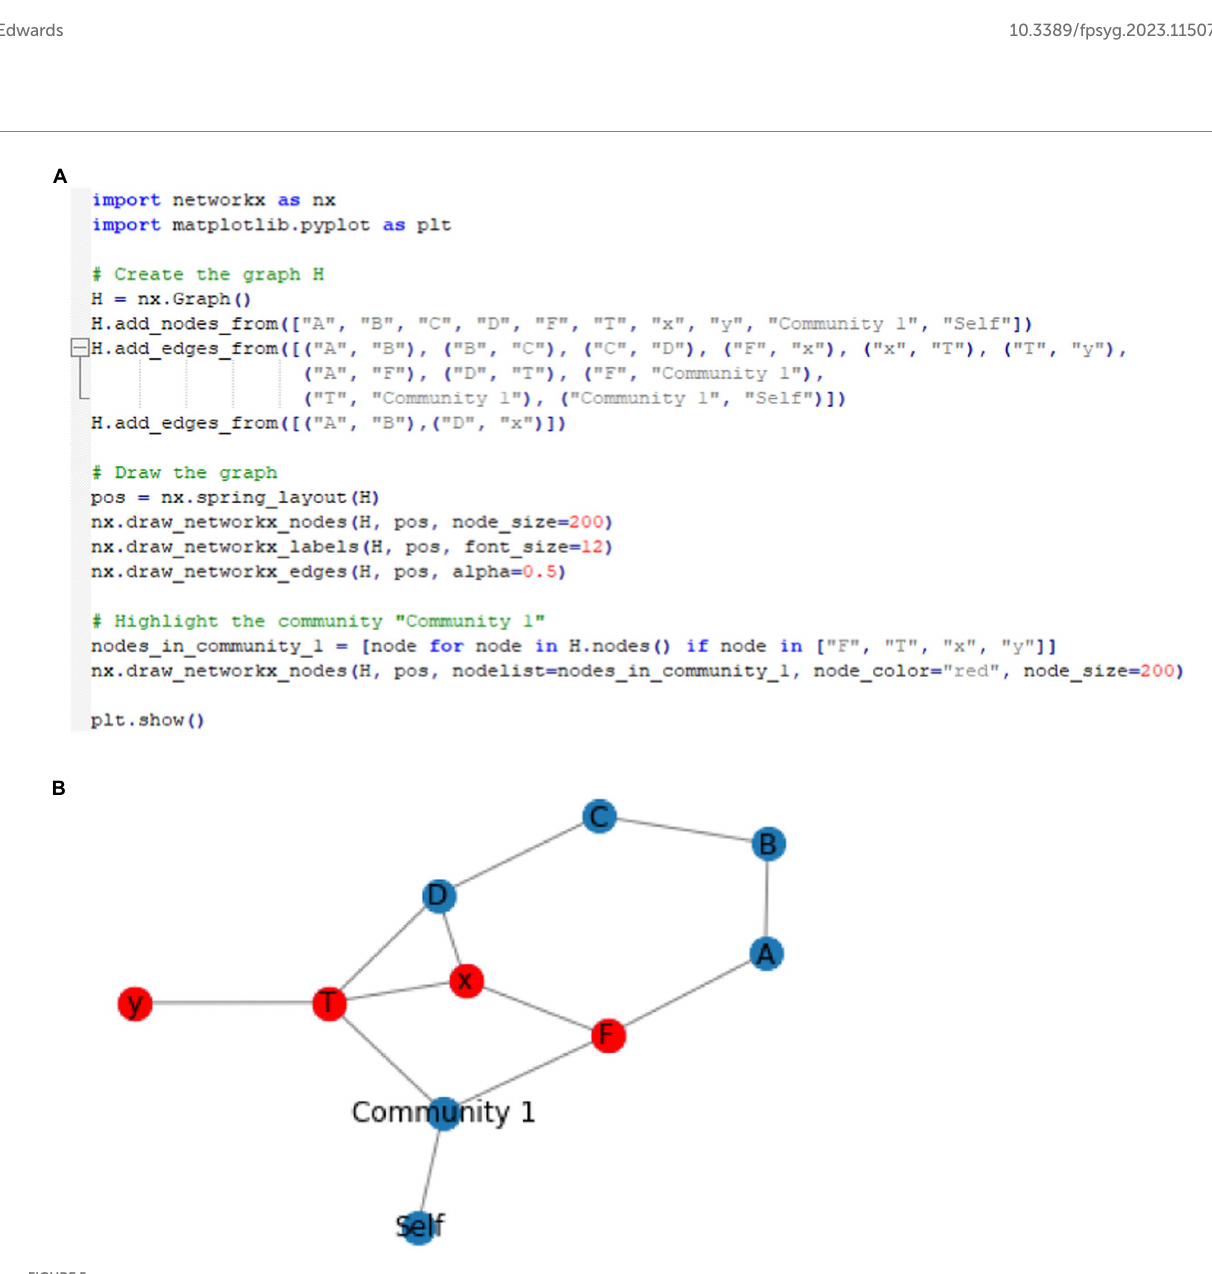
FIGURE 5 (A) Example of Python code for specifying two communities, and the resultant community network where the ToF community (function T node) within a broader relational network can be visualized within the graph. (B) Visual areas of interest within the network may be an area that a PBT therapist would consider targeting to undermine its negative impact across the network. It also shows in the resultant visualized network whether the ToF function T transfers fear F of snake x to local woods y